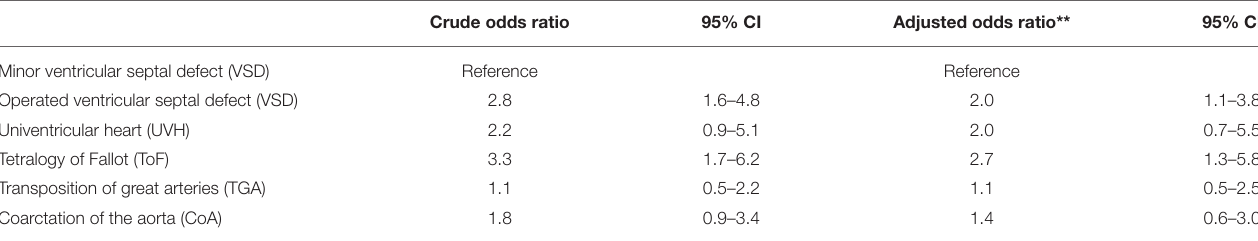
TABLE 3 | Odds ratios of SGA (severe and intermediate vs. normal) for different types of isolated CHD by ordinal logistic regression. Crude odds